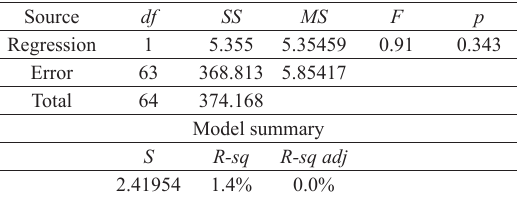
Table 7. Analysis of Variance: Radial Tension versus 45-A Orientation Tension Strengths.